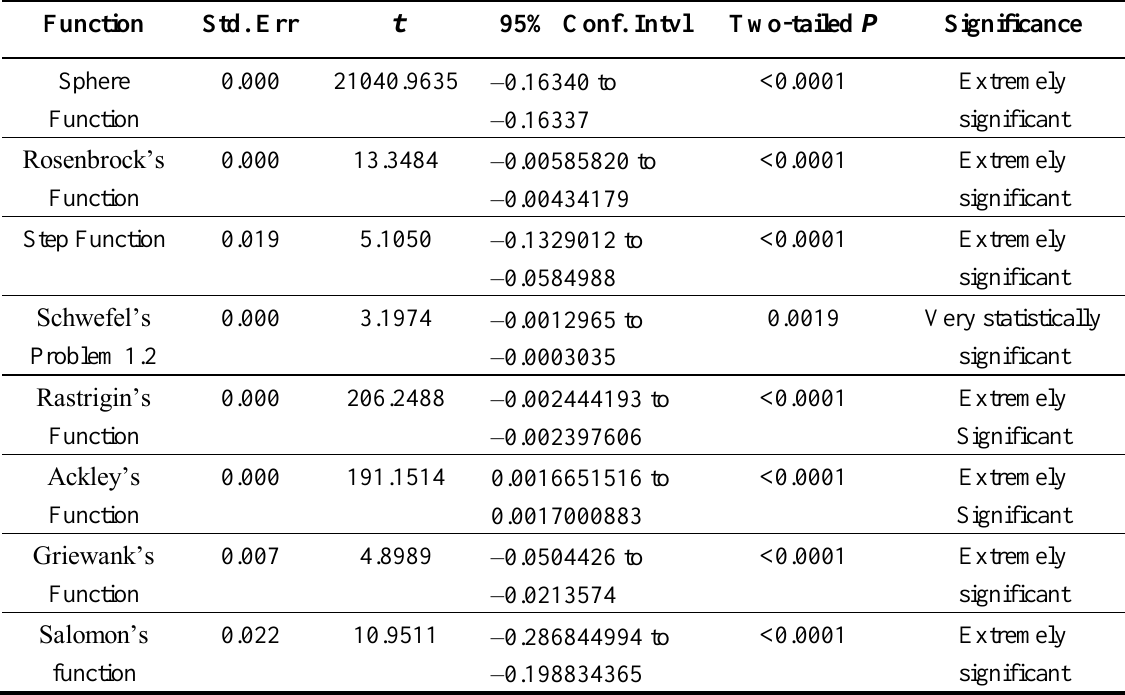
Table 7. Results of unpaired t-tests on the data of Table